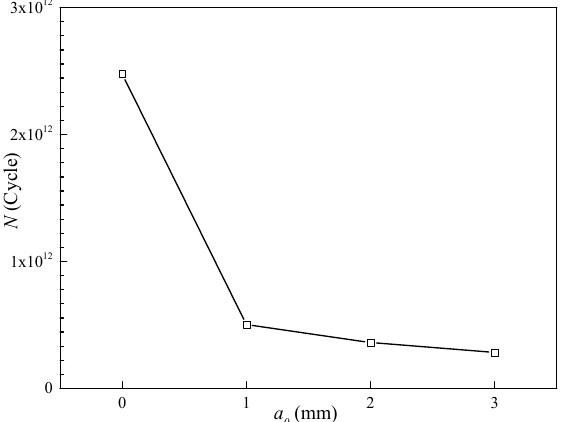
Figure 12. Relationship between initial crack length a 0 and fatigue life N.